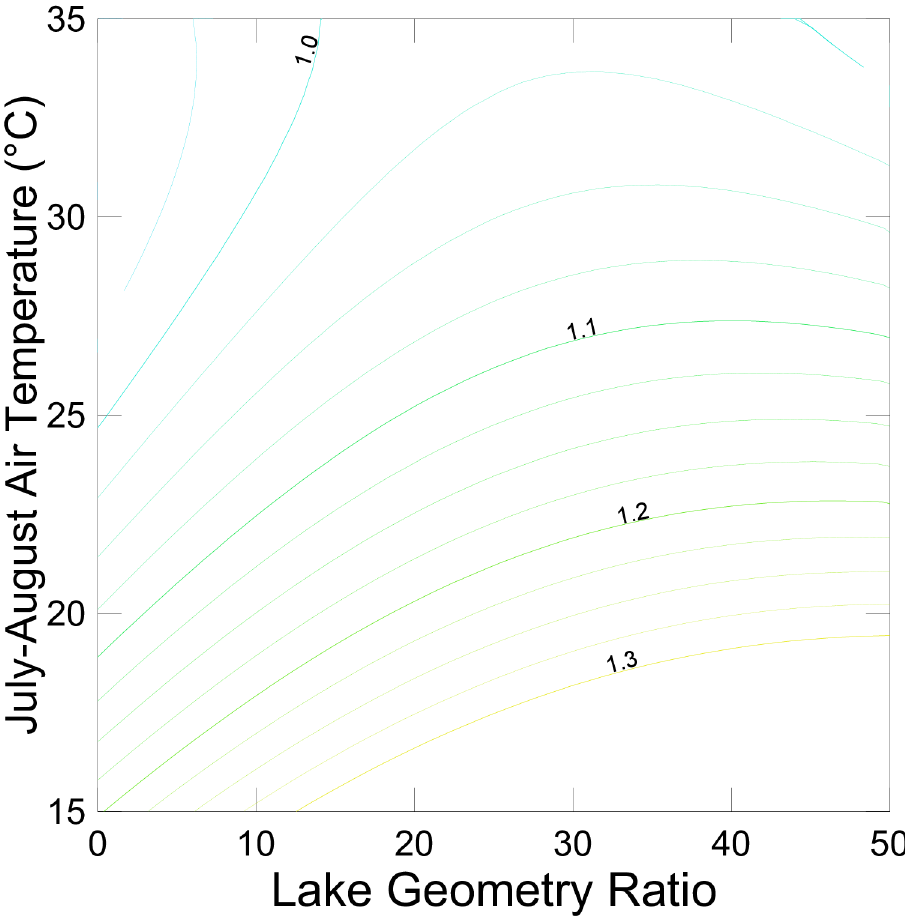
Fig 1. Change in MWAT above the thermocline as a function of July-August air temperature and lake geometry ratio in the training data (with quadratic smoother applied).